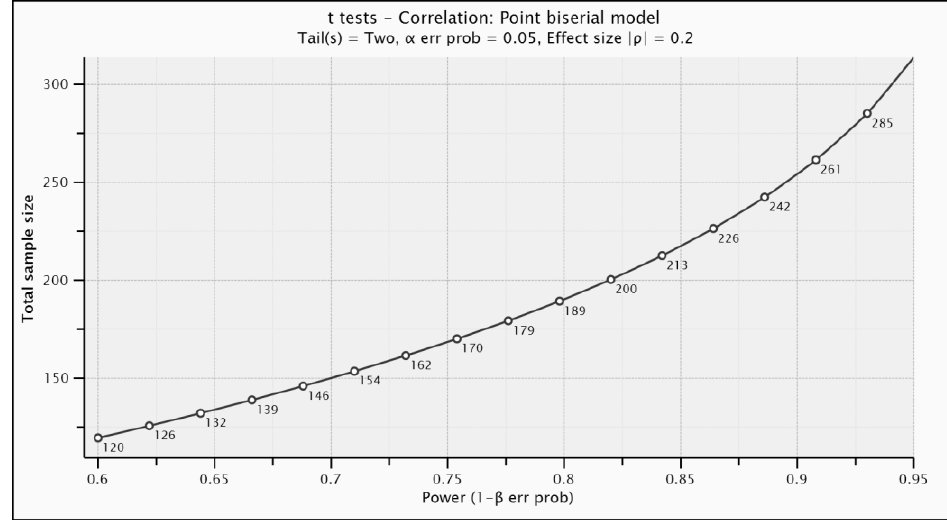
Figure 1. A priori statistical power analysis to determine the minimum recommended sample size.